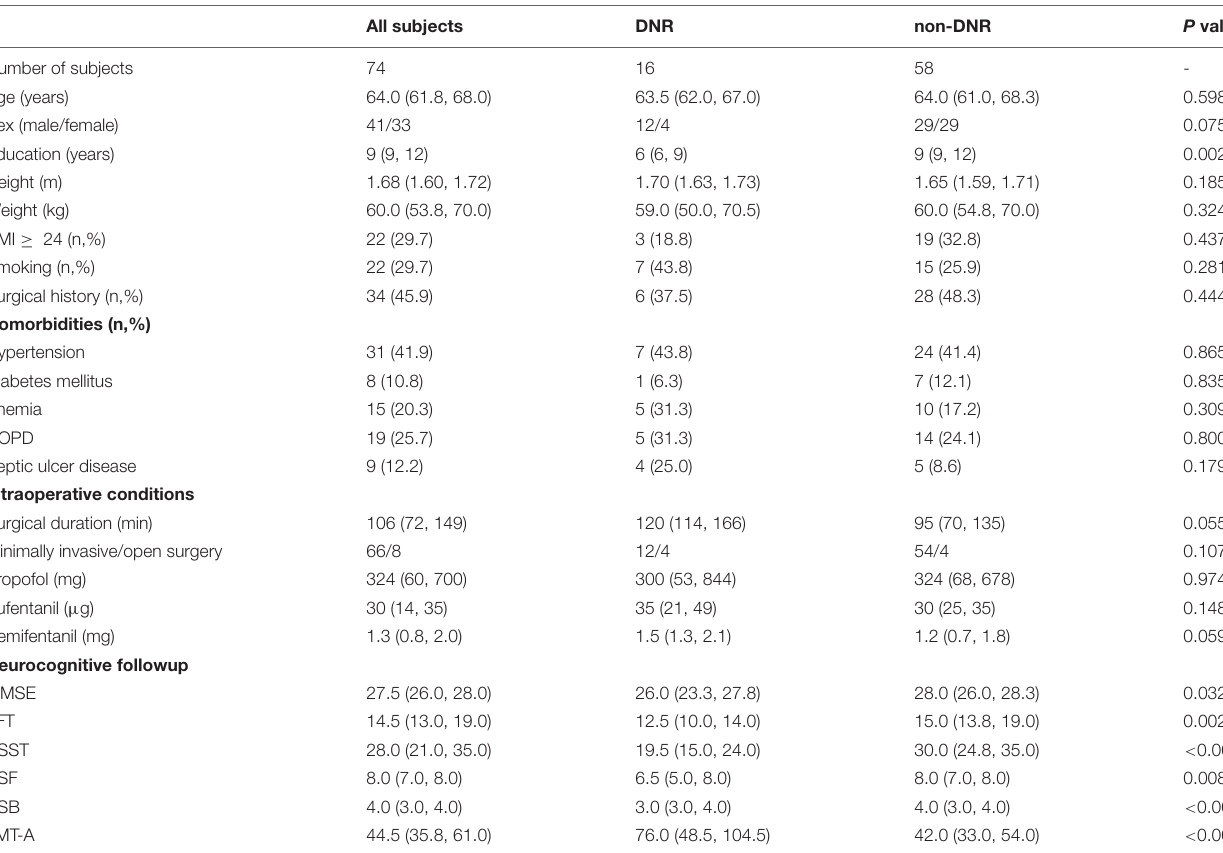
TABLE 1 | Characteristics and neurocognitive